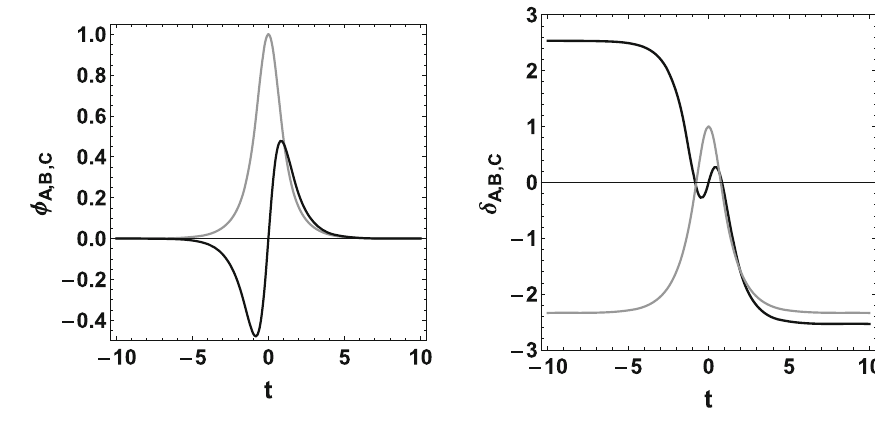
Fig. 10 Evolution of δ and (cid:23) for models A , B and C . The behavior of these quantities are similar for the first three model. The black curves are plotted for initial values δ( 0 ) = 0 , δ (cid:8) ( 0 ) = 1 ,(cid:22)( 0 ) = 0 and (cid:22) (cid:8) ( 0 ) = 1 and the gray ones are drawn for δ( 0 ) = 1 ,δ (cid:8) ( 0 ) = 0 , (cid:22)( 0 ) = 1 and (cid:22) (cid:8) ( 0 ) =